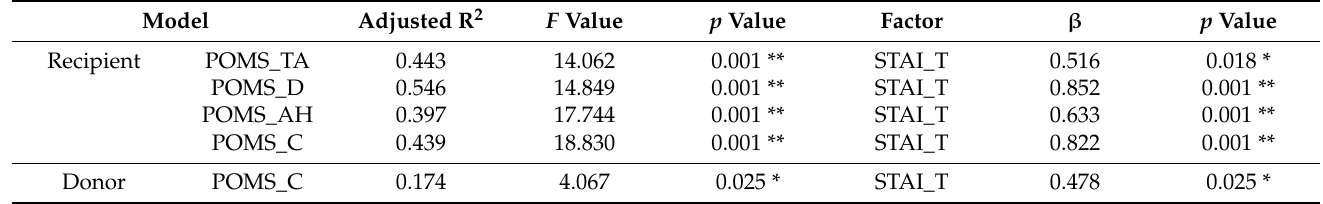
Table 7. Significant impact factors of STAI on choosing between PEKT and PDKT. Multicollinearity was suspected if the VIF value was greater than 10. * p < 0.05, ** p < 0.01: significant effects of STAI scores on the direct/secondary impact factors for choosing between PEKT and PDKT among recipients and donors according to stepwise multiple regression analysis with robust standard